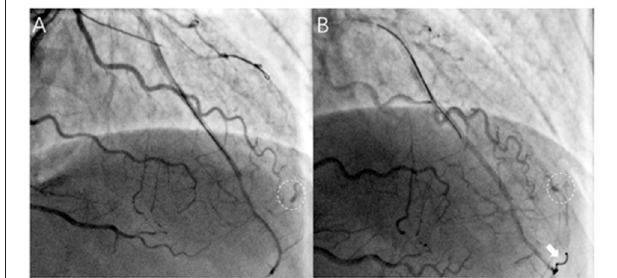
FIGURE 3 | Acquired coronary fistulas uselessly and unnecessarily treated with coil embolization in a patient. (A) After successful recanalization of the LAD, ACFs were visualized and difficult to identify with coronary perforation timely (circle); (B) Rattled and successful delivery of one coil through the microcatheter (Finecross, Terumo, Japan) (arrows), but ACFs still existed (as shown in circle), and pericardial effusion was not found on echocardiography. ( Supplementary Movies 9 , 10 show angiographic findings).